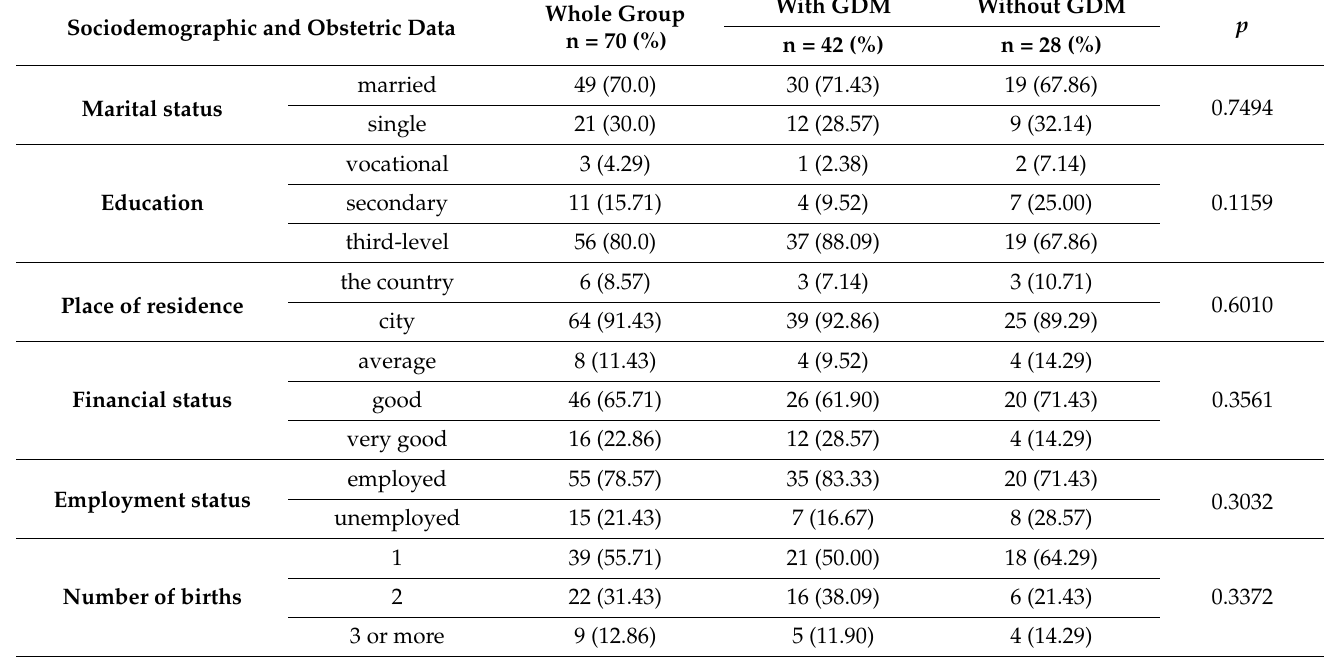
Table 1. Sociodemographic